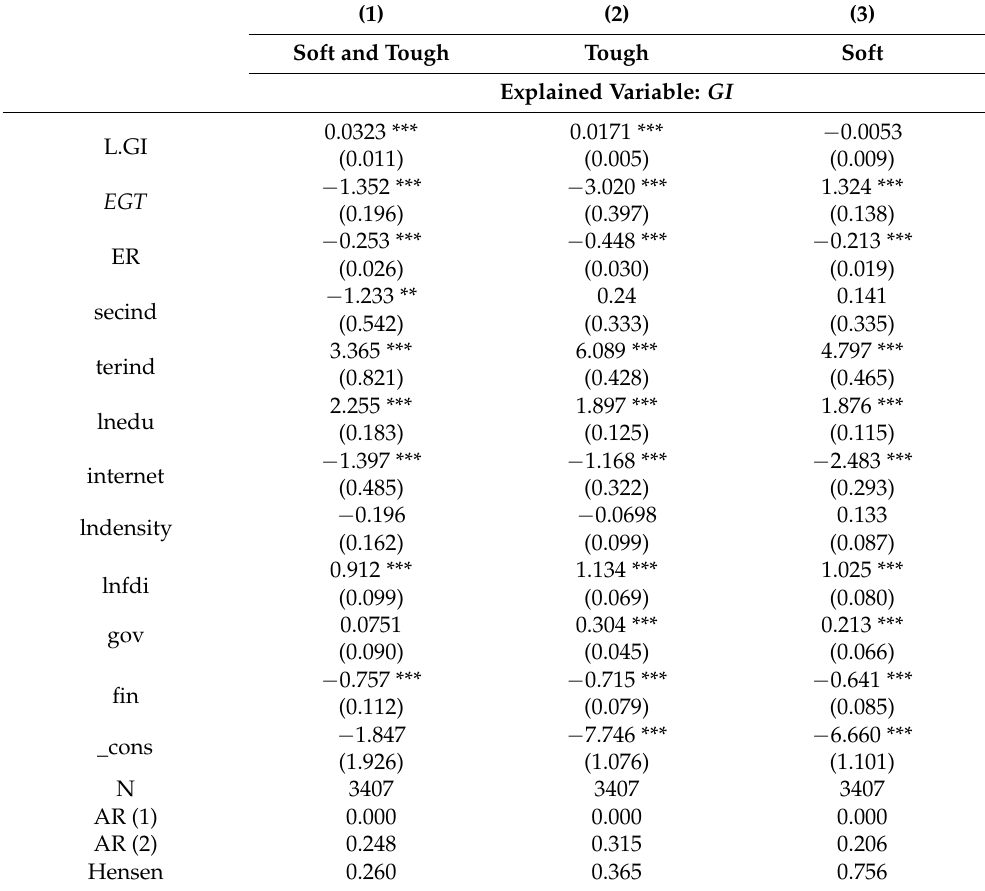
Table 4. Economic target constraint